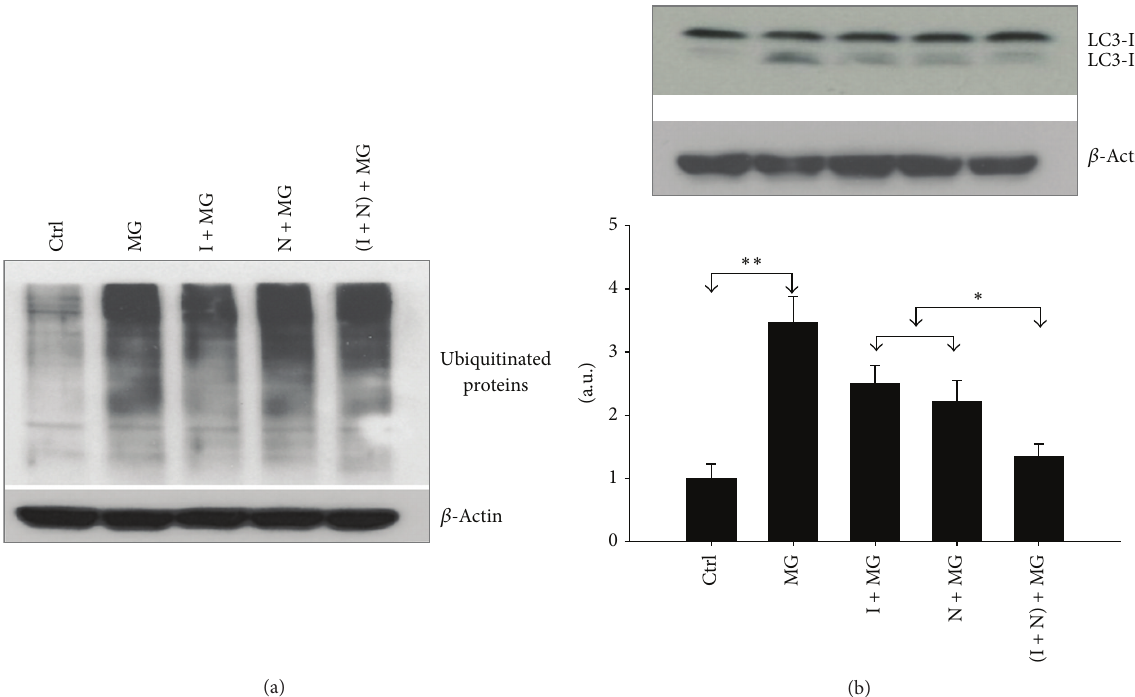
Figure 4: IGF-1 and NAC reduce MG132 induced autophagy without changing amounts of ubiquitinated proteins. After each treatment (indicated in the figure), total cell lysates were prepared for Western blot against ubiquitin and LC3B (an autophagy marker) antibodies. (a) Western blot for ubiquitinated protein. (b) Western blot analysis for LC3. 𝛽 -Actin served as the loading control. Level of significance is denoted as ∗ 𝑝 ≤ 0.05 and ∗∗ 𝑝 ≤ 0.005 .